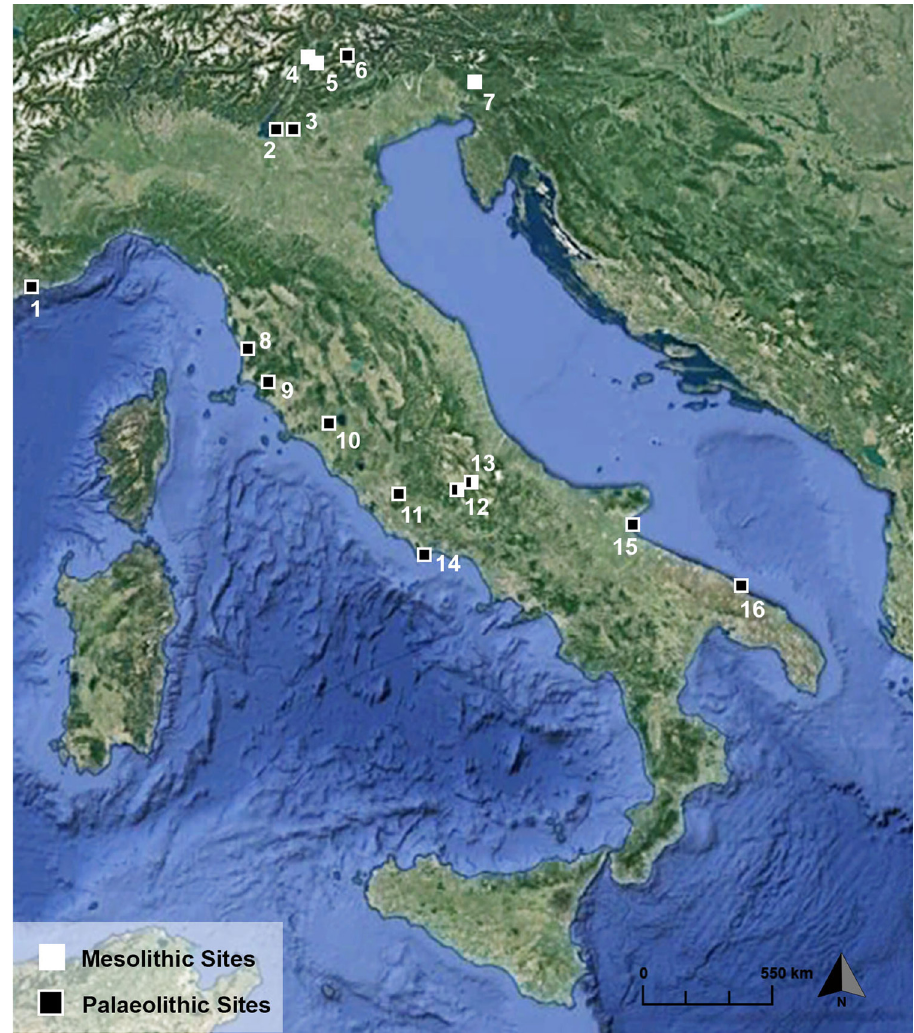
Figure 1: Distribution map of the Italian Mesolithic and Palaeolithic sites mentioned in the text: ( 1 ) Riparo Bombrini - Balzi Rossi; ( 2 ) Fumane Cave; ( 3 ) Riparo Tagliente; ( 4 ) Riparo Gaban; ( 5 ) Riparo Romagnano; ( 6 ) Riparo Villa Bruna; ( 7 ) Riparo Biarzo; ( 8 ) Monterotondo; ( 9 ) Gavorrano; ( 10 ) Settecannelle Cave; ( 11 ) Polesini Cave; ( 12 ) Continenza Cave; ( 13 ) Pozzo Cave; ( 14 ) Fossellone Cave; ( 15 ) Paglicci Cave; and ( 16 ) Delle Mura Cave. ( Map Data: Google Earth Pro 7.3, Data SIO, NOAA, U.S. Navy, NGA, GEBCO; Image Landsat/Copernicus, elaboration by A.Vassanelli )